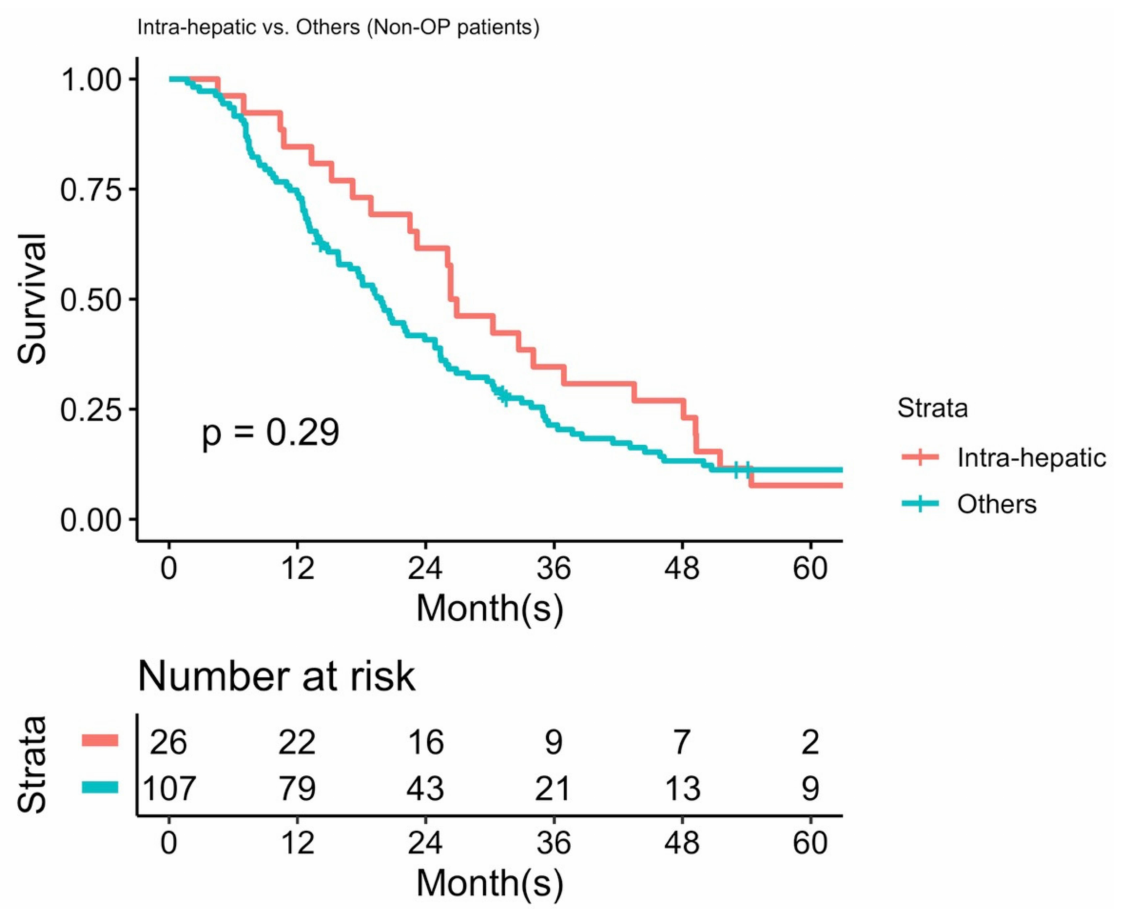
Figure 7. The difference in post-recurrence overall survival (PROS) between the nonoperative patients within group A and the nonoperative patients within groups B and